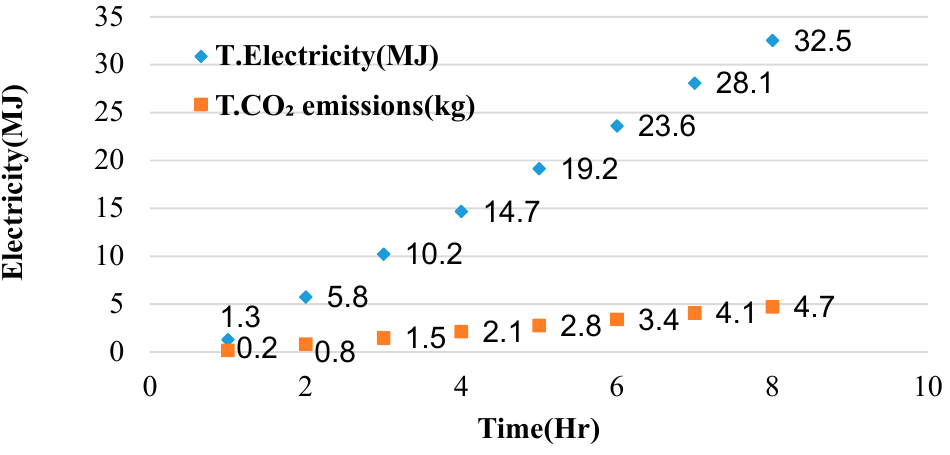
Figure 5. Daily electricity uses by Flax/PLA composite tape machine during a single manufacturing process (Tilsatec).